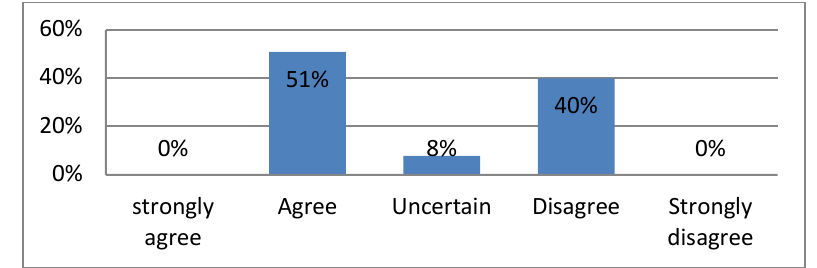
Figure 3 : advertisement affect the buying